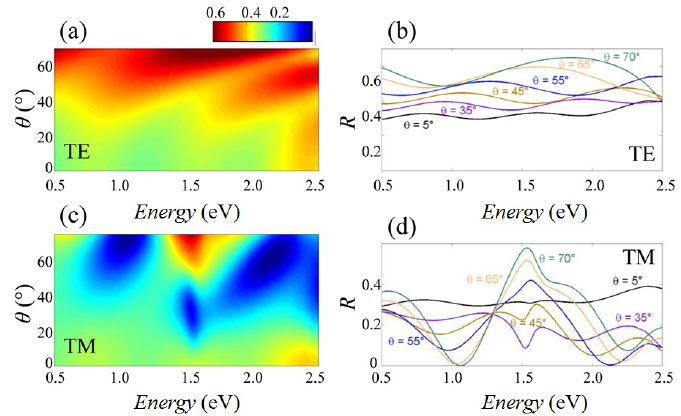
Figure 3. Effective-medium calculation of reflectance modulations. Logarithmic color plot of the angle- and energy-resolved reflectance calculated for InAs NWs using the effective-medium approximation for ( a ) TE polarization and ( c ) TM polarization, respectively. Reflectance spectra calculated at several different angles, for ( b ) TE and ( d ) TM polarizations.